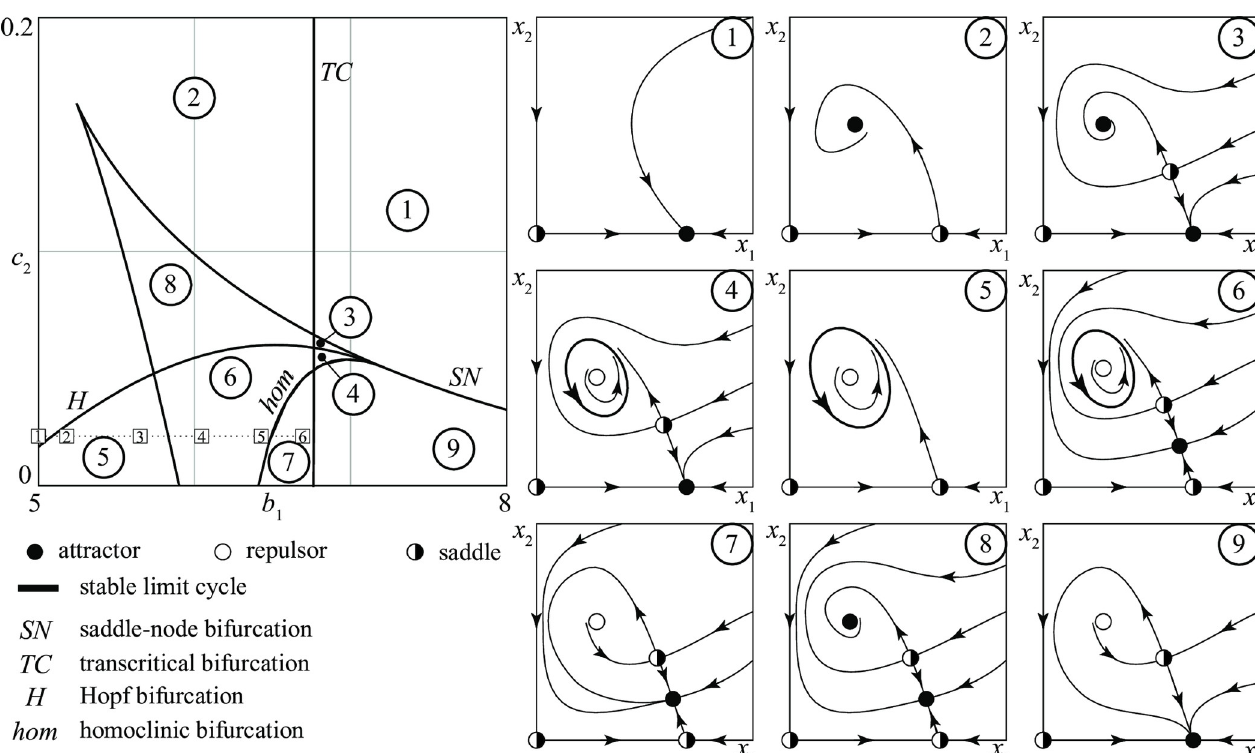
Fig 7. Example of a bifurcation diagram of a D—A